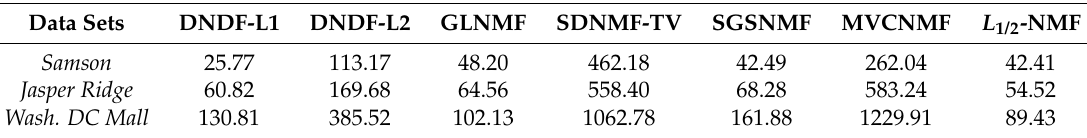
Table 4. Running time on three real data sets (in